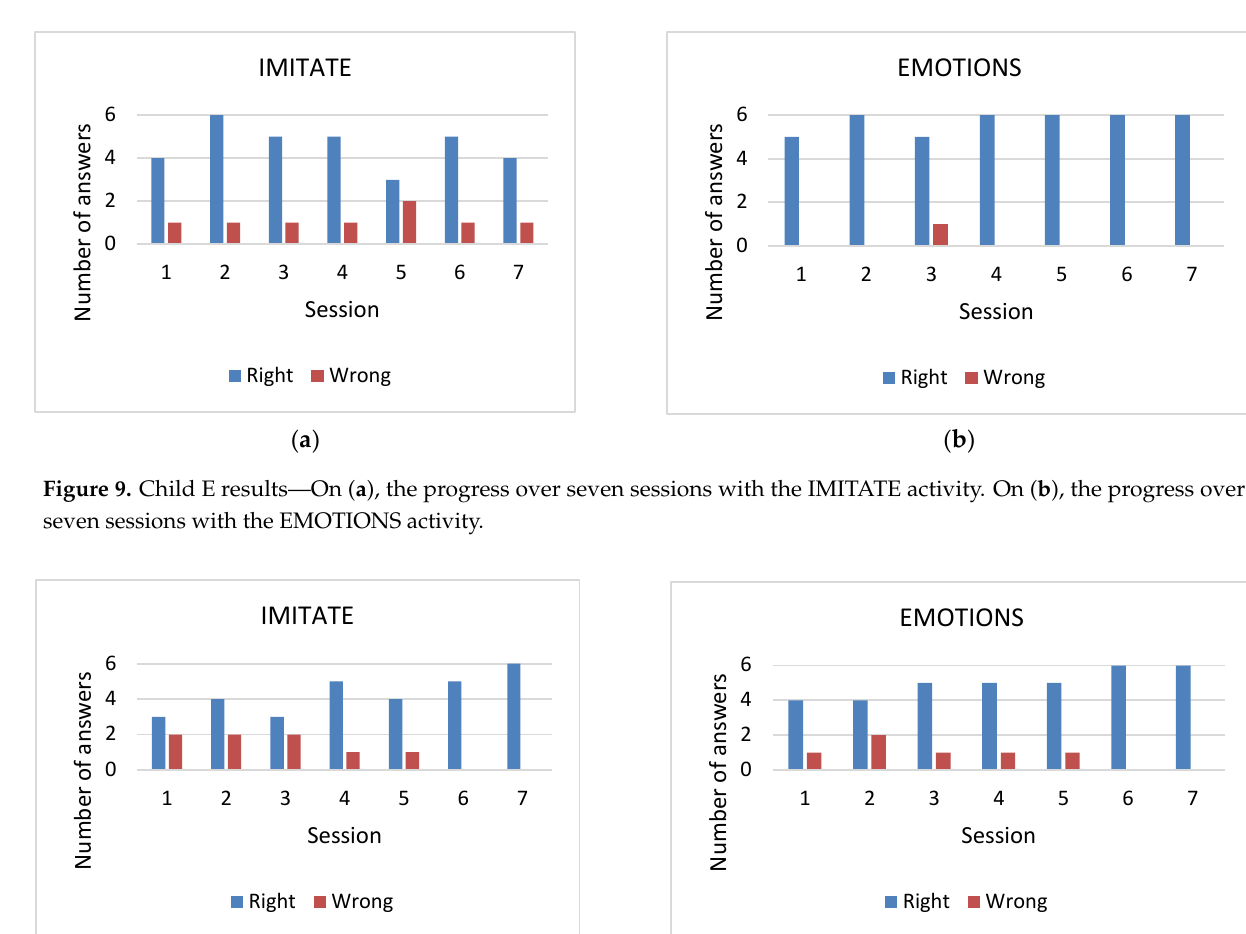
seven sessions with the EMOTIONS activity.